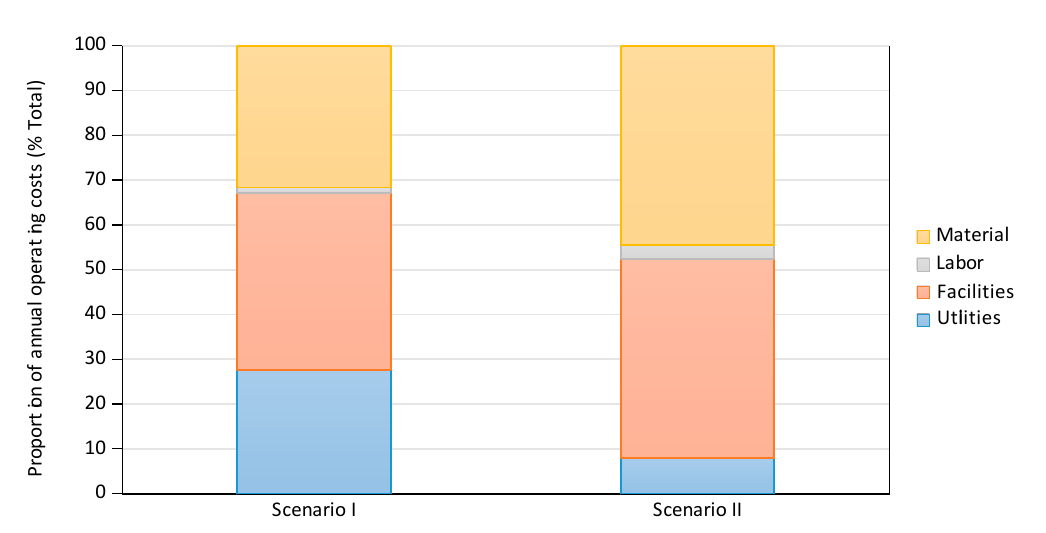
Figure 5. Proportion of annual utility costs for Scenario I (evaporation process) and Scenario II (flocculation process).